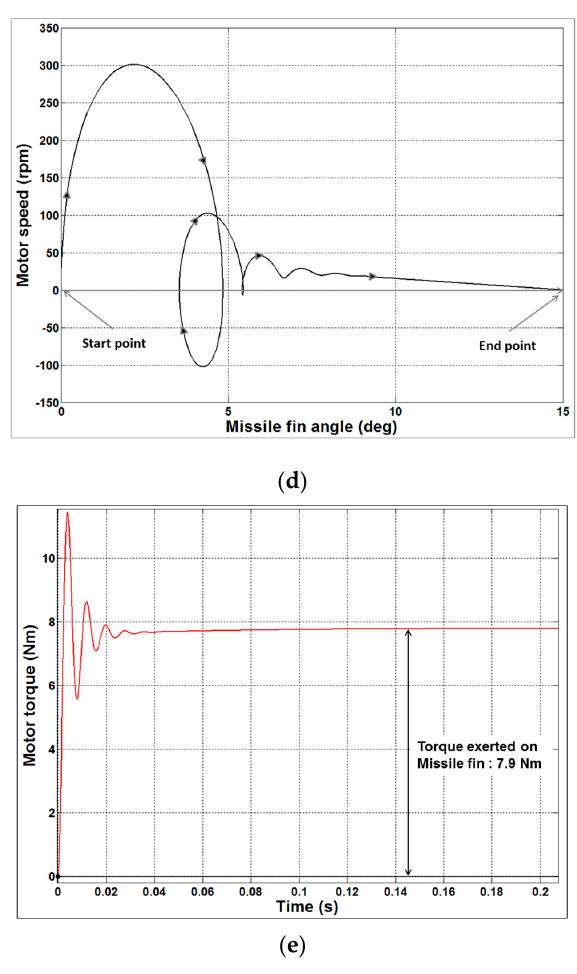
Figure 8. Step input response of the actuator. ( a ) Steady-state and dynamic characteristics of the actuator for a 15° step input; ( b ) Angle response of the actuator for a 15 ° step input; ( c ) Speed characteristics of the actuator for a 15° step input; ( d ) Actuator speed with respect to missile fin angle for a 15° step input; ( e ) Torque characteristics of the actuator for a 15 ° step input.